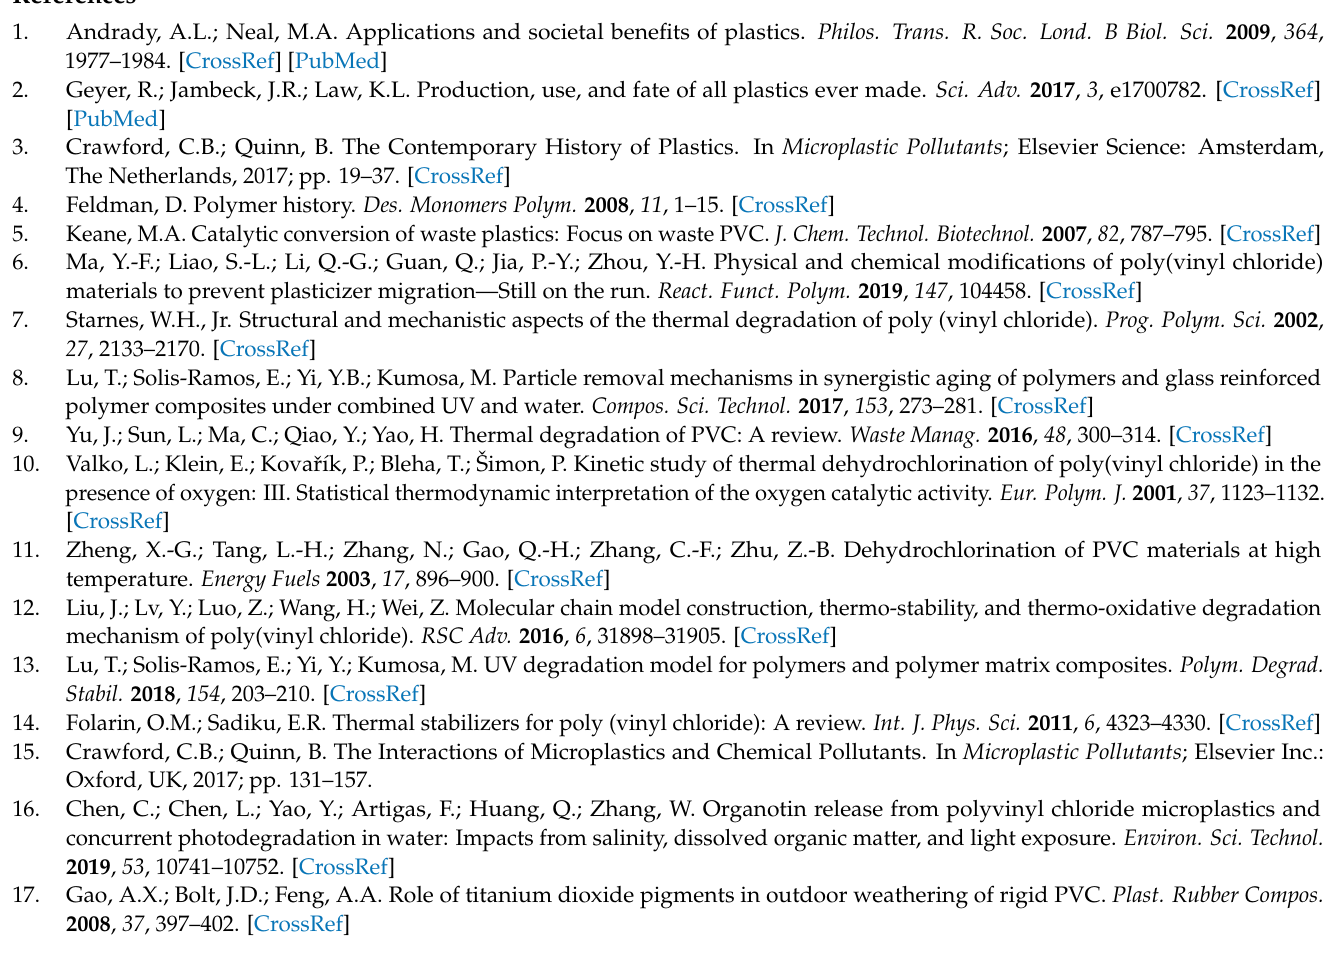
SEM images of PVC film (a): before irradiation and (b): after irradiation. Figure S4: SEM images of irradiated PVC films containing (a): complex 1 , (b): complex 2 , (c): complex 3 , and (d): complex 4 . Figure S5: two- and three-dimensional AFM images of the blank PVC film (a): before irradiation and (b): after irradiation. Figure S6: two- and three-dimensional AFM images of irradiated PVC films containing (a): complex 1 , (b): complex 2 , (c): complex 3 , and (d): complex 4